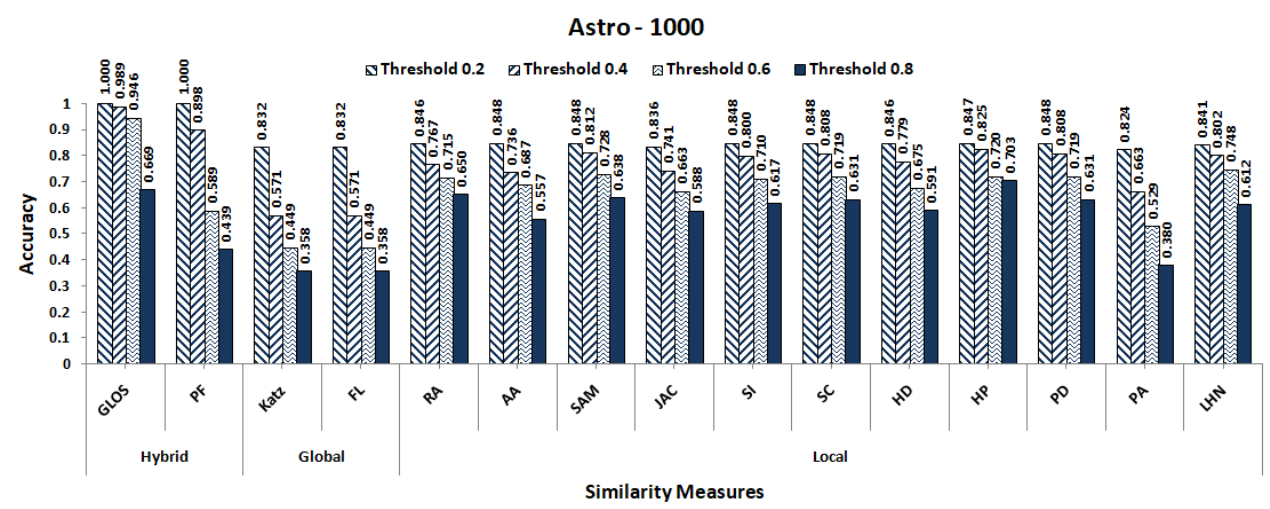
Figure 7. Comparisons of similarity measures on Astro-1000 edge list from Astro dataset